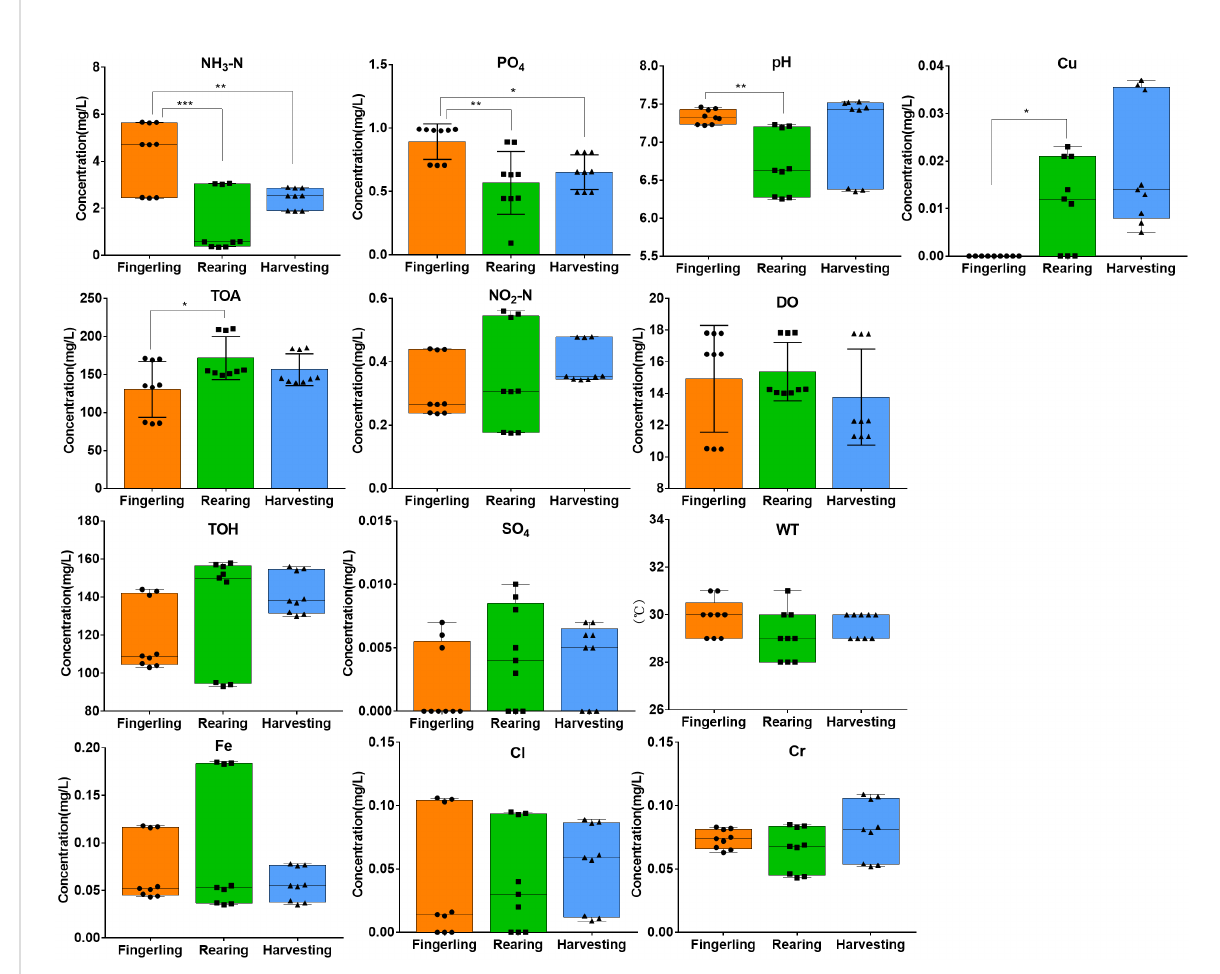
FIGURE 3 Concentrations of NH 3 -N, PO 4 , Cu, TOA, NO 2 -N, DO, TOH, SO 4 , Fe, Cl, and Cr and values of water temperature and pH in the water samples. *, P < 0.05; **, P < 0.01; ***, P <